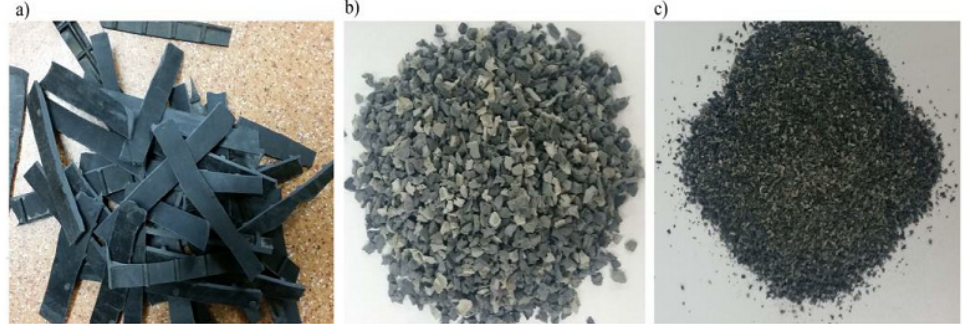
Figure 1. Post-consumer waste from used car liners: preshredded material ( a ); shredded to 2–8 mm fraction ( b ); shredded to 0–2 mm fraction ( c ) [55]. Table 1. Composition of the mixture of control concrete and waste-modified concretes as a substitute for sand and gravel aggregate of grain size 2–8